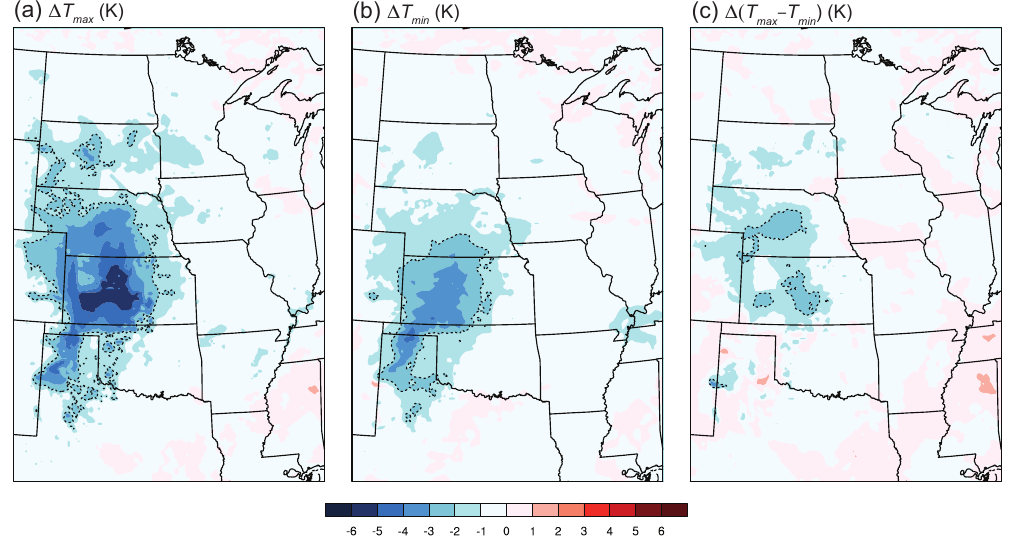
Figure 5. Differences in monthly-mean 2-m temperatures between IRR and CTL simulations for July. ( a ) Daily maximum temperature; ( b ) Daily minimum temperature; ( c ) Diurnal temperature range, the difference between maximum and minimum temperature. Contour units are K, with the –2 K contour represented by the dotted